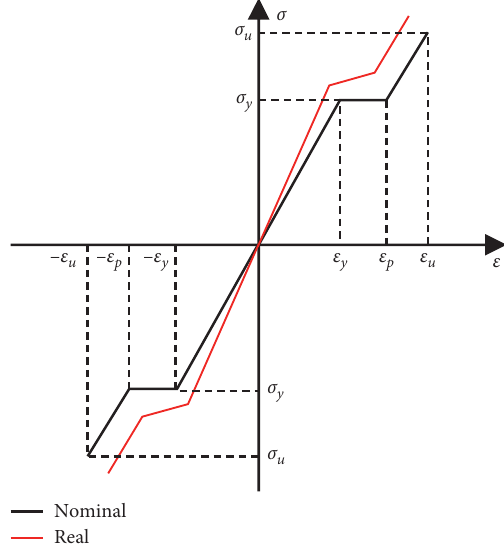
Figure 7: Strain-stress relationship of the EDP.